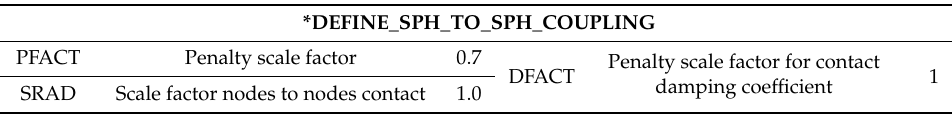
Table 2. Selected contact parameters as defined in LS-DYNA for